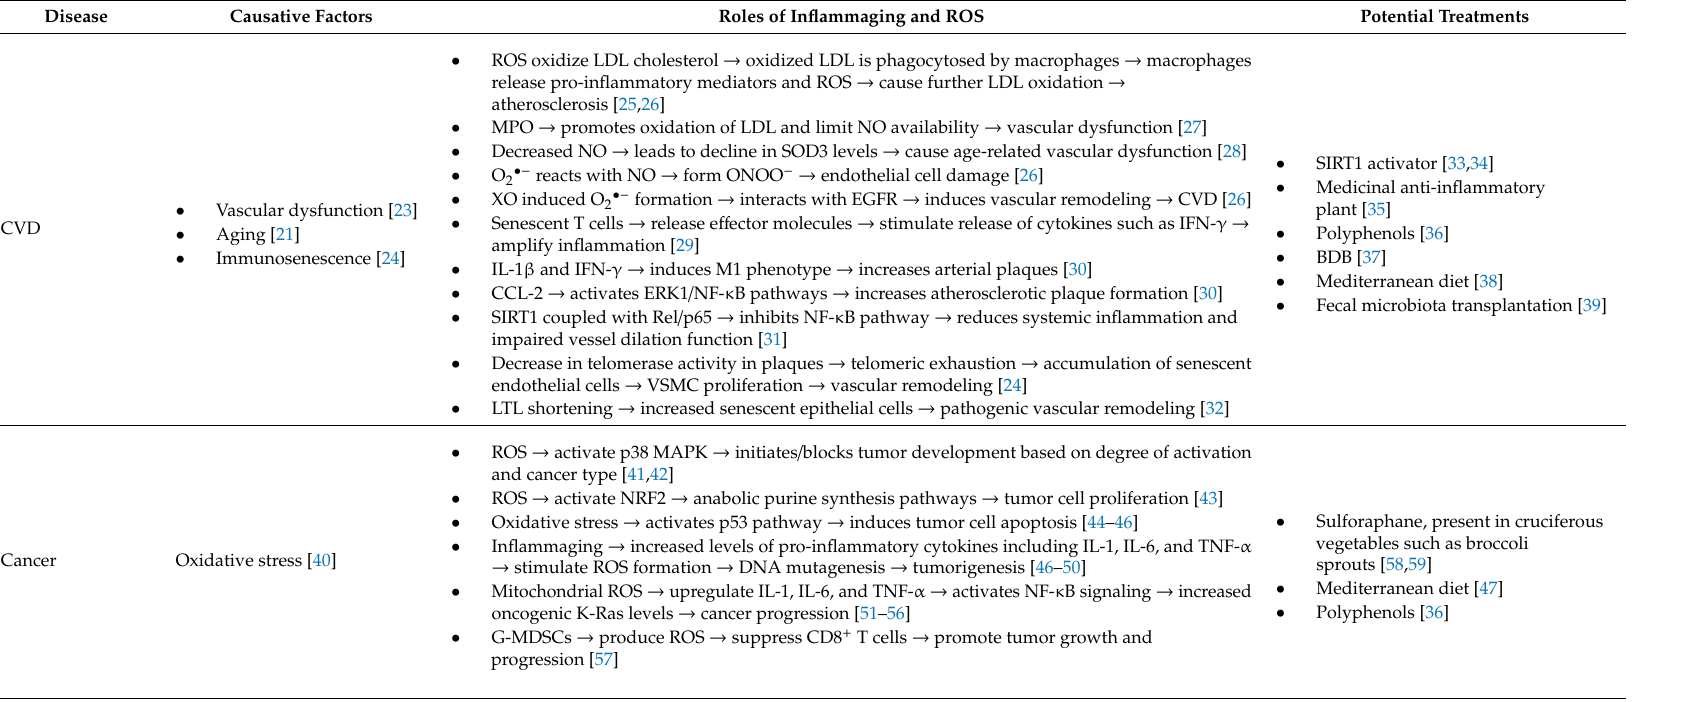
Table 1. Causative factors, roles of inflammation, oxidative stress, and treatment strategies of age-related diseases including CVD, cancer, neurodegenerative diseases, COPD, diabetes, and